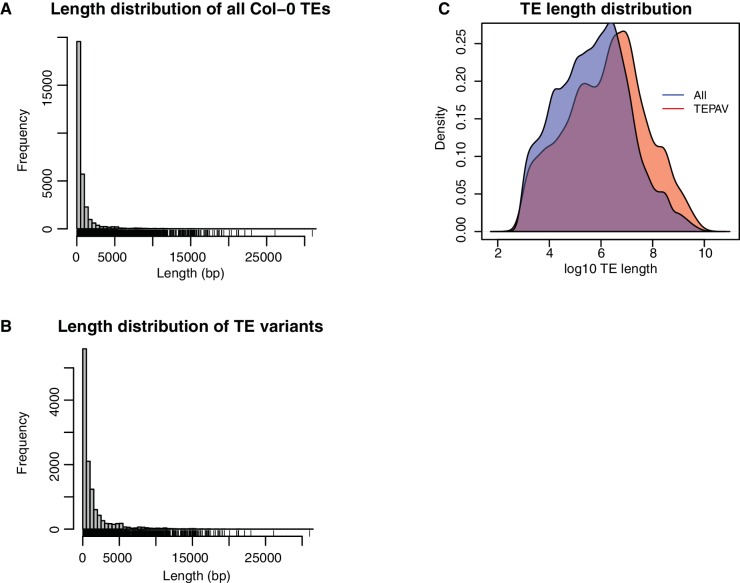
Length distribution for all Col-0 TEs and all TE variants. (A) Length distribution for all annotated TEs in the Col-0 reference genome. (B) Length distribution for all TE variants. (C) Density distribution of log10 TE length for all Col-0 TEs (red) and TE variants (blue).